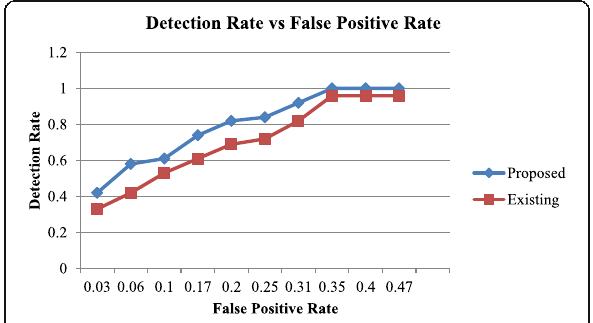
Fig. 4 Detection rate vs. false positive rate. False positive rate and detection rate are plotted. The relationship between the false positive rate and detection rate are presented